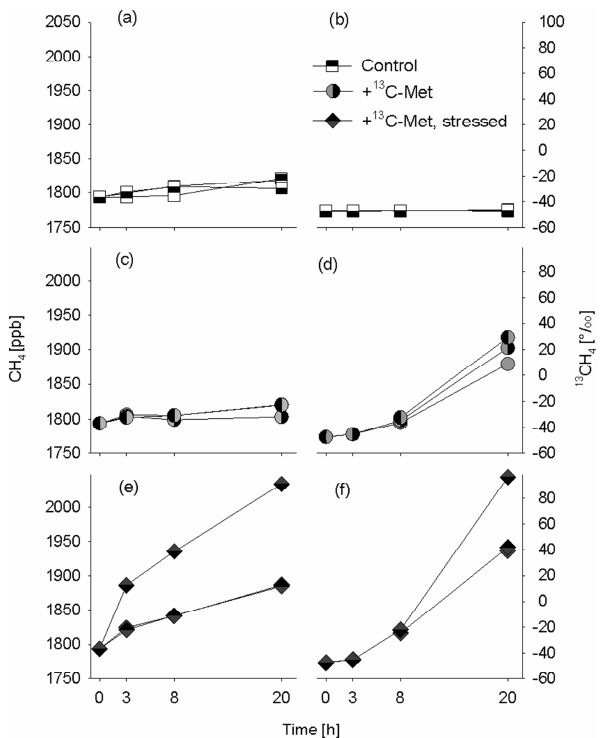
Figure 1. Mixing ratios (a, c, e) and δ 13 C values (b, d, f) of CH 4 produced by L. angustifolia ( n = 3) in the control flasks (a, b) with- out addition of methionine or physical stress, supplemented with 13 C-labeled Met without physical stress (c, d) and supplemented with 13 C-labeled Met and the application of physical stress (e, f) . Different symbols mark the replicates per